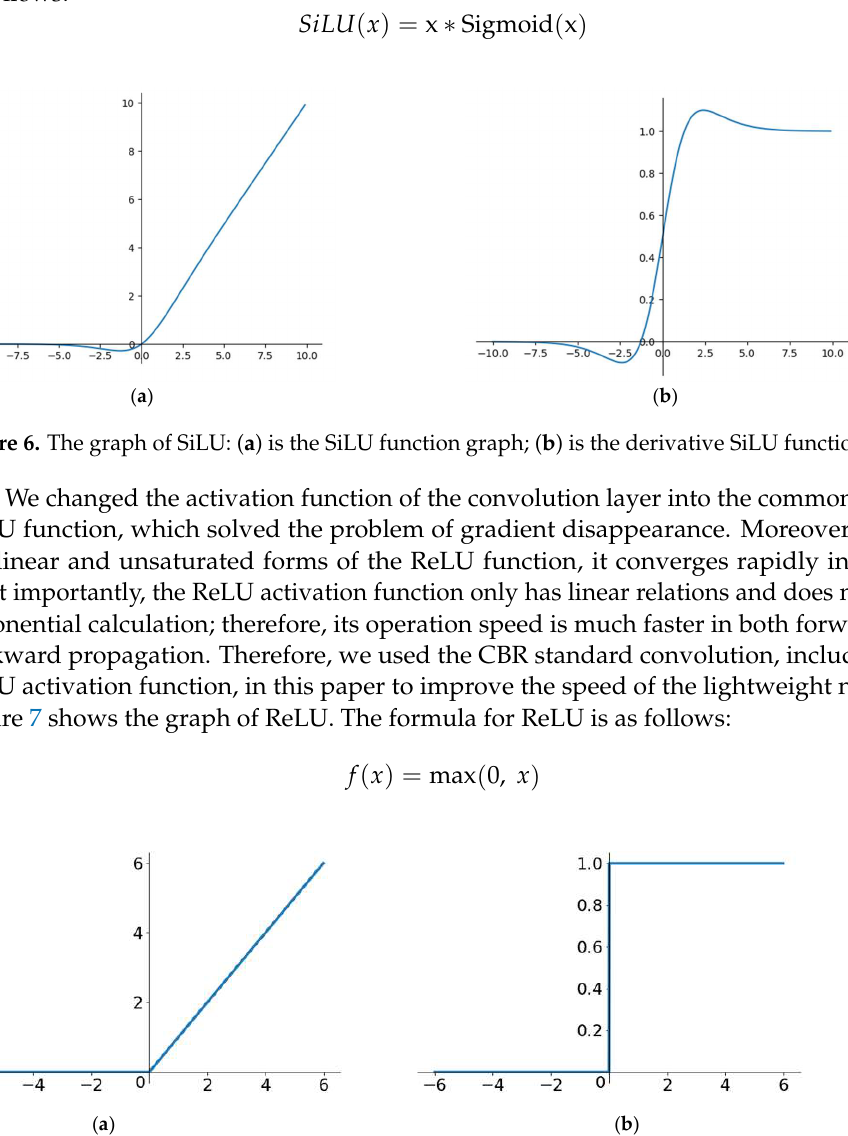
Figure 7. The graph of ReLU: ( a ) is the graph of the ReLU function; ( b ) is the derivative graph of the ReLU function.